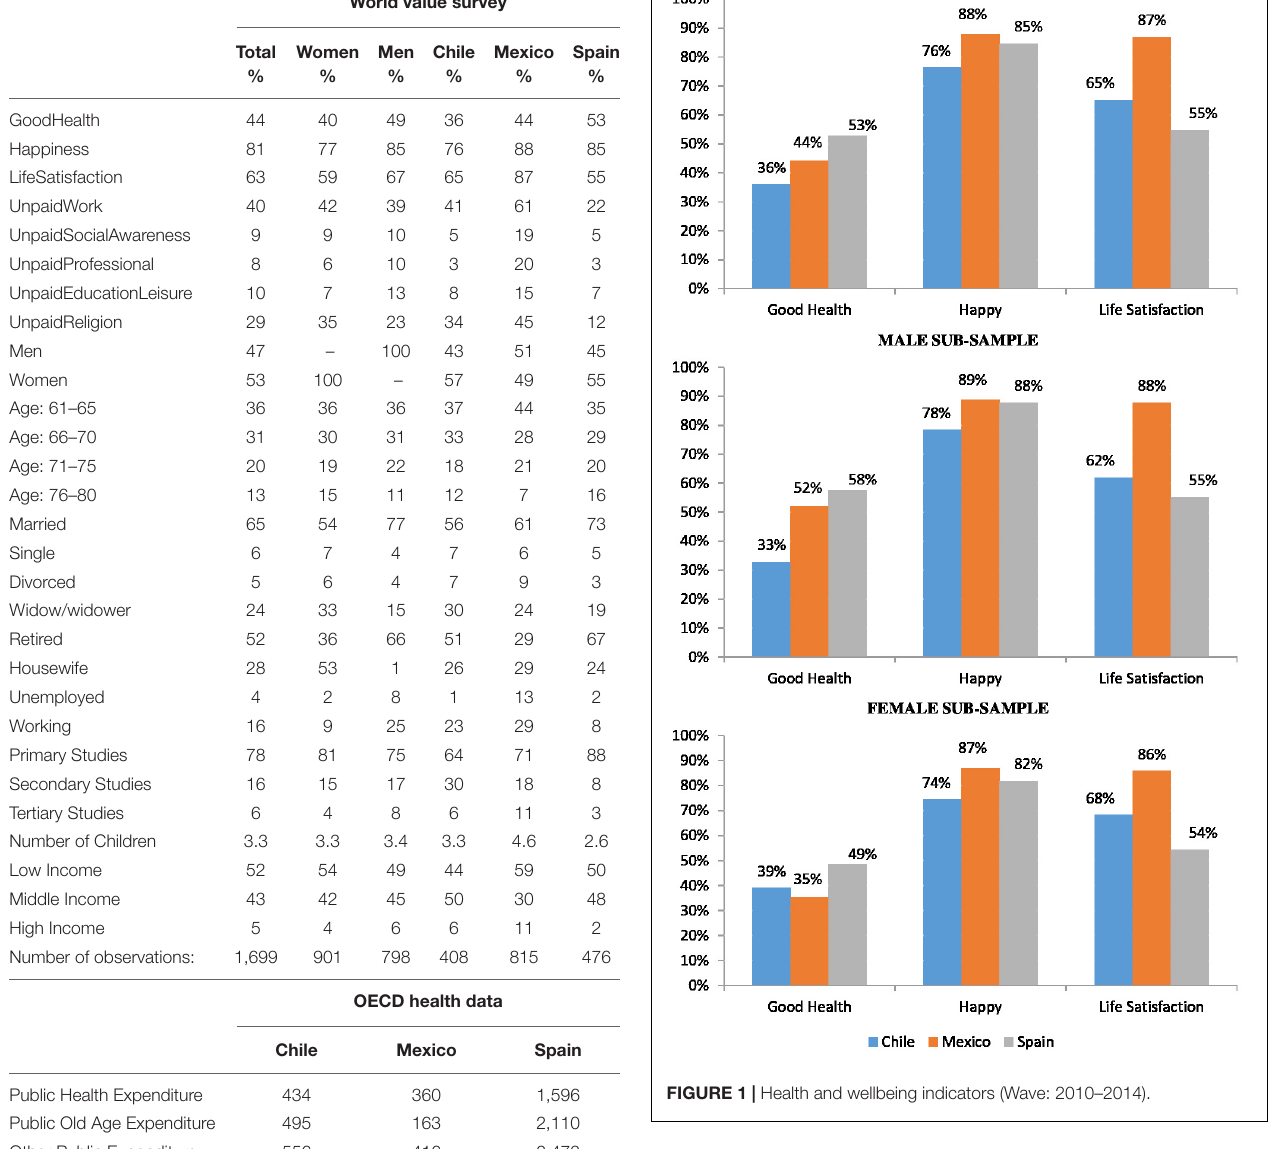
World value survey